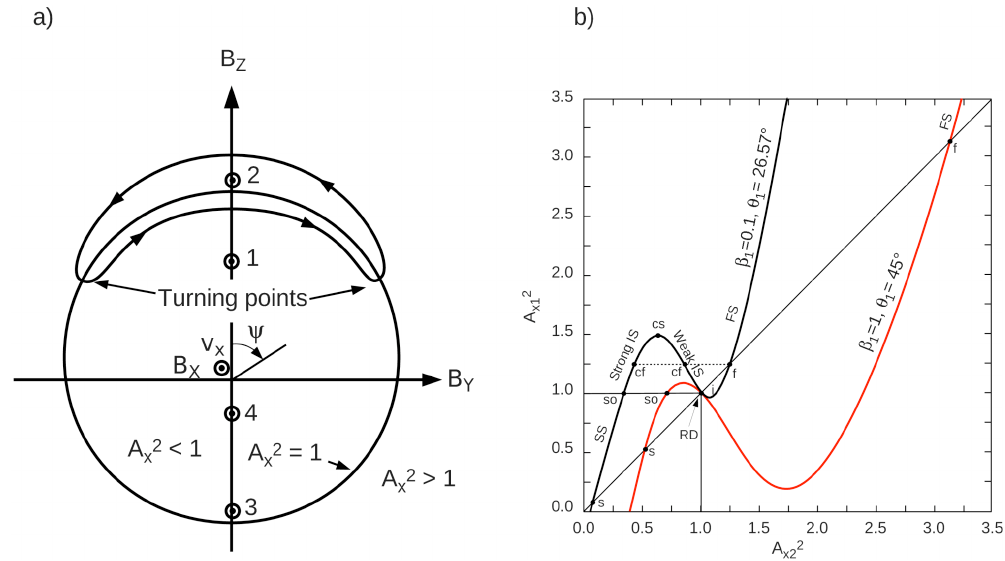
Fig. 2. MHD shock properties. (a) Schematic drawing, showing the location of fixed points in the tangential hodogram plane. These four points represent the possible upstream and downstream states of fast shocks (1 → 2), weak and strong subfast intermediate shocks (2 → 3, or 2 → 4), and slow shocks (3 → 4). Superfast intermediate shocks (1 → 3 and 1 → 4) can also occur. Also shown is a banana-shaped hodogram trace, around the fixed point 2, for a non-dissipative wave train. This trace marks the successive locations, as the normal coordinate x increases, of the head of an arrow from the origin, representing the tangential magnetic field vector. The indicated sense of motion around the banana is for the case where (v x /B x ) is positive. (b) Representation of shock jump conditions in terms of upstream ( A x1 ) and downstream ( A x2 ) Alfv´en numbers for two different sets of values of upstream plasma beta, β 1 , and angle, θ 1 , between shock normal and upstream field. Acronyms FS, IS, and SS represent fast, intermediate, and slow shocks. The symbols s , i , and f , denote small-amplitude slow, intermediate, and fast modes; the switch-off shock is denoted by so . Superfast intermediate shocks occur above the line cf-cf-f (after Hau and Sonnerup, 1989).